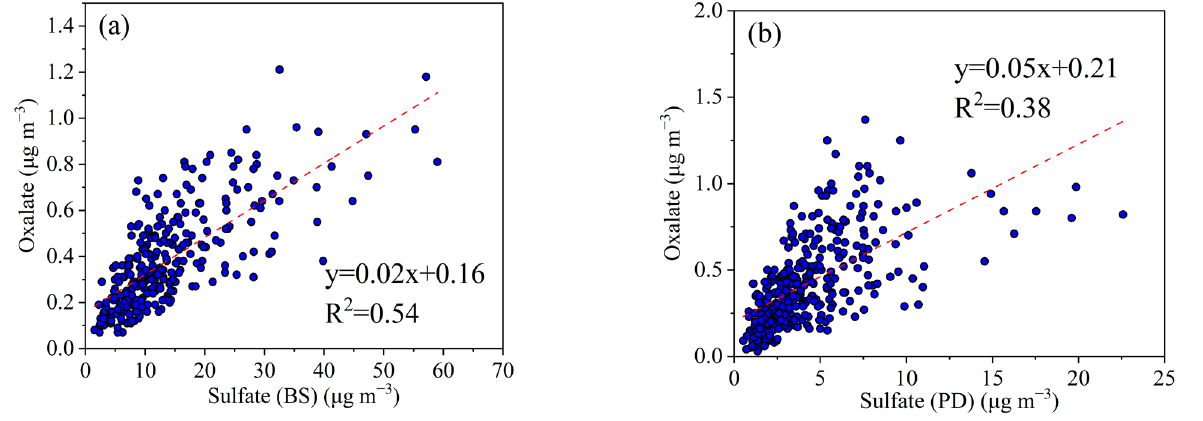
Figure 4. Oxalate correlation with sulfate: BS ( a ) and PD( b ).